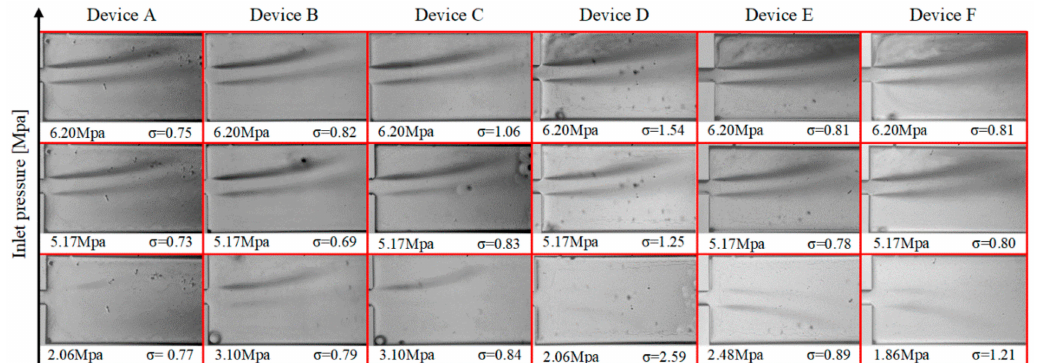
Figure 5. The flow patterns of six microfluidic devices in the extension section of the devices along with the inlet pressure and cavitation